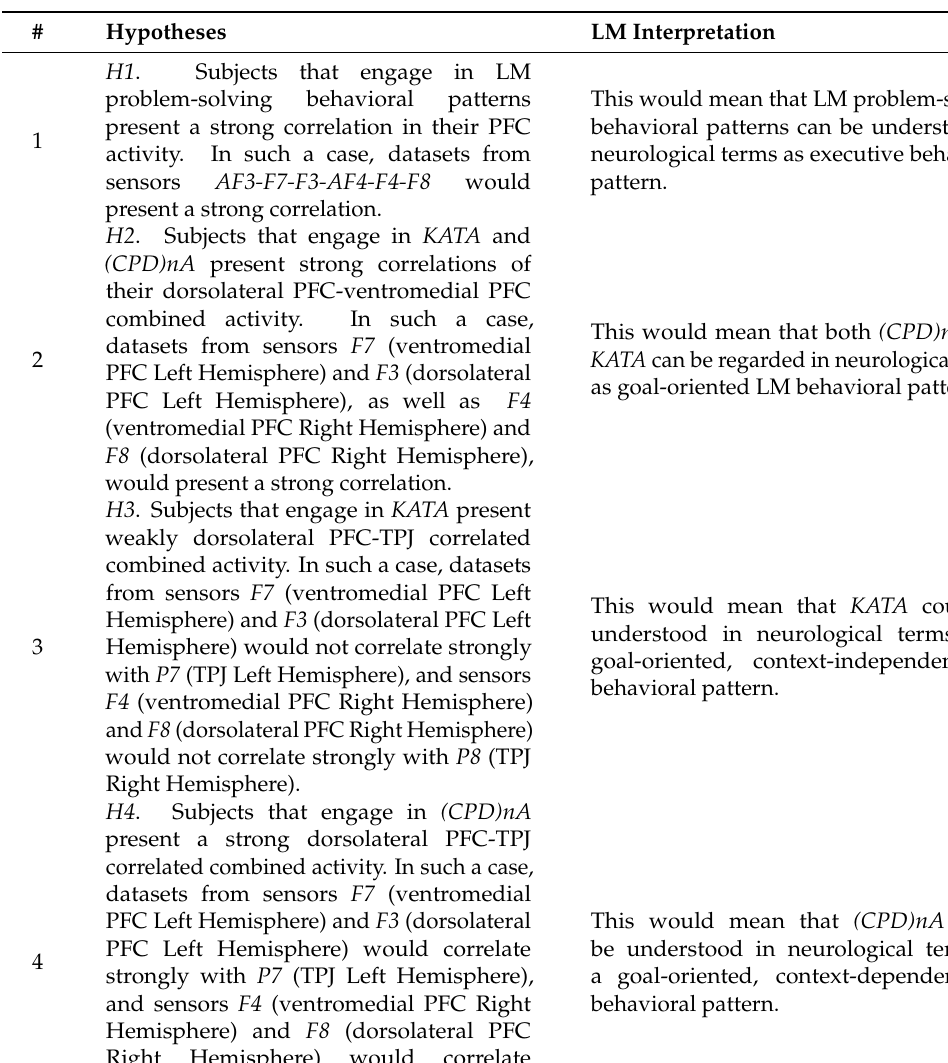
Table 1. Research questions and related